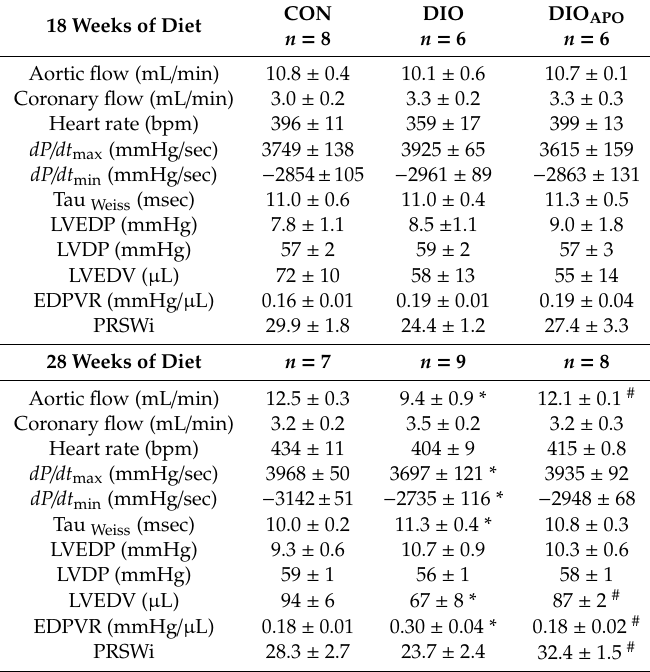
Table 4. Steady state and load-independent parameters of left-ventricular (LV) function obtained in isolated perfused working hearts from chow-fed controls (CON) and diet-induced obese C57BL / 6J mice with or without apocynin treatment (DIO and DIO APO